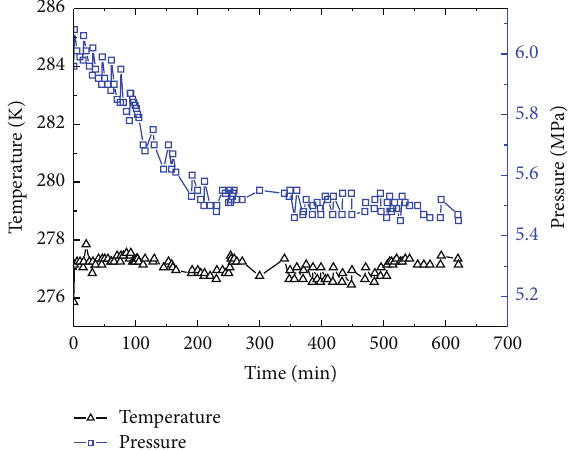
Figure 2: Temperature and pressure of hydrate formation in SDS